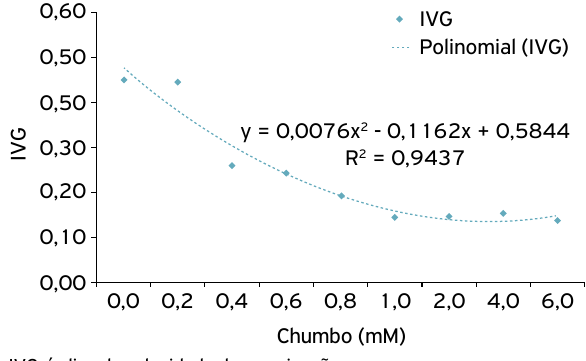
Figura 5. Índice de velocidade de germinação do chumbo em sementes de Schinus terebinthifolius